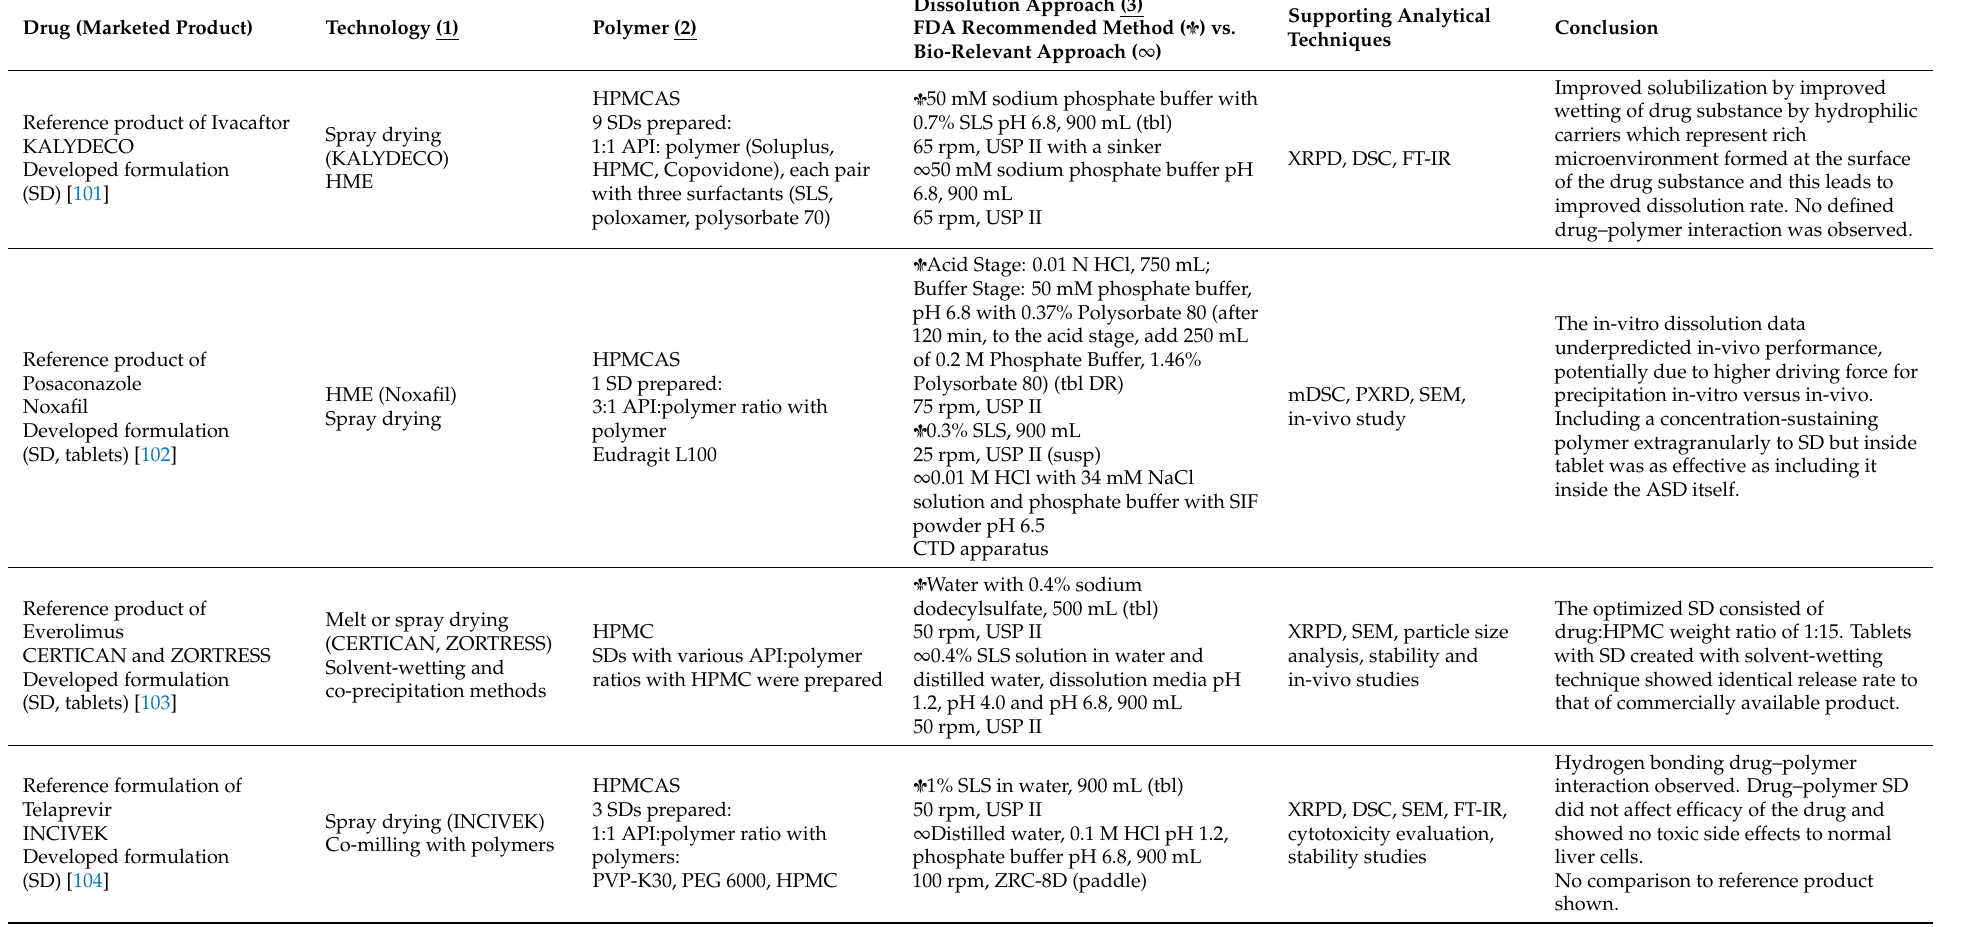
Table 2. Review of dissolution studies on amorphous solid dispersion formulations.